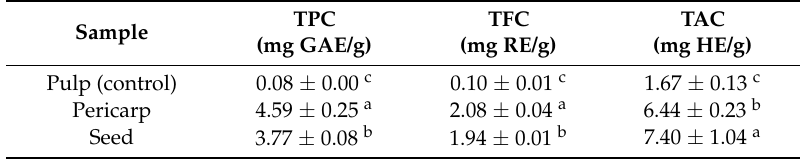
Table 1. Total phenolic, flavonoid and alkaloid contents in longan fruits.